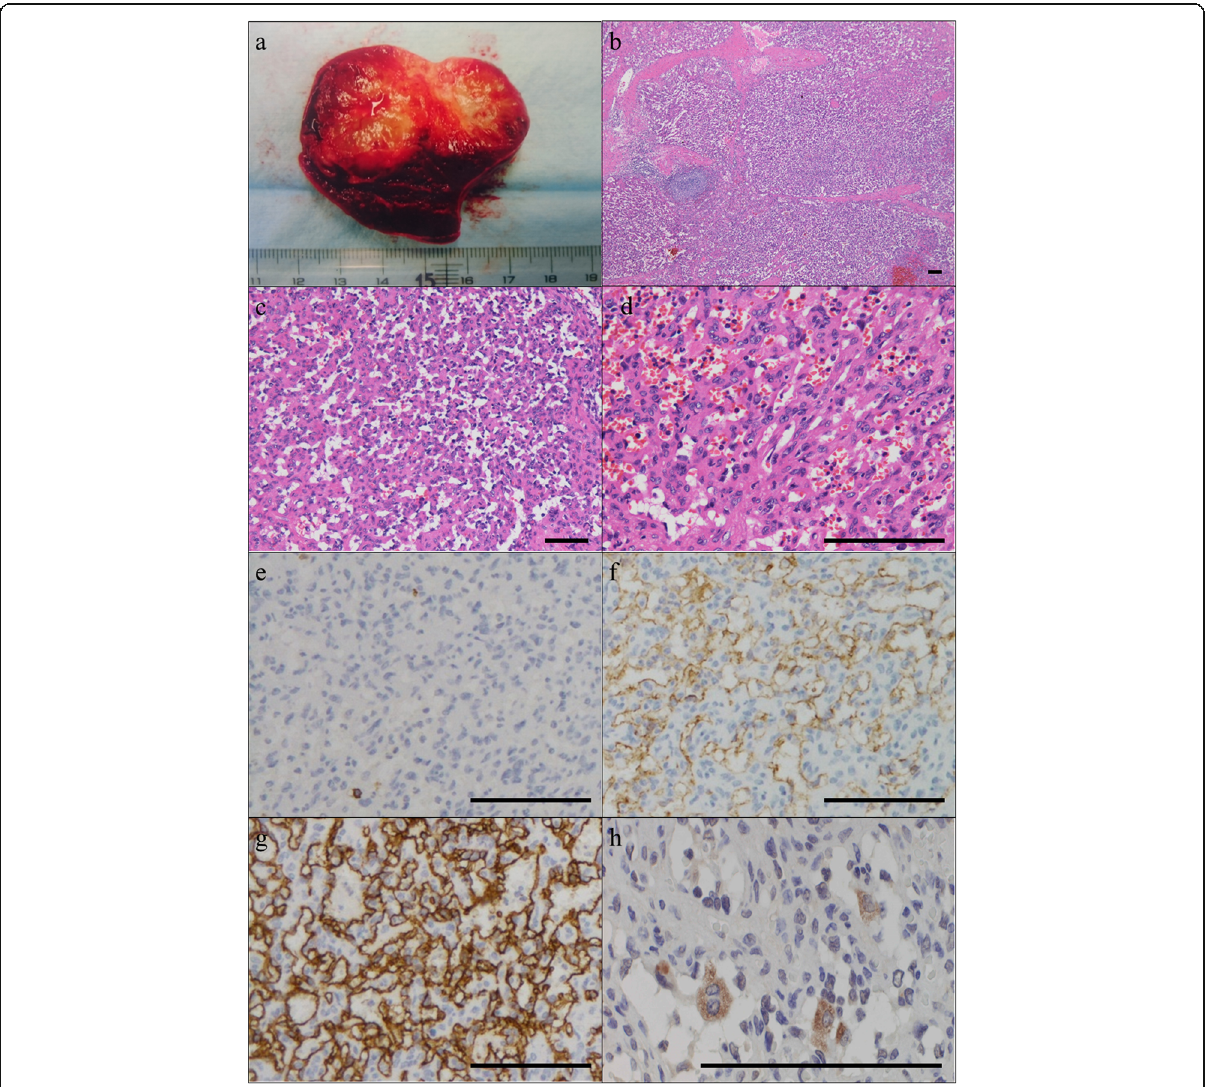
Fig. 2 Macroscopic and microscopic findings. ( a ) Macroscopic findings. The solid tumor (3.5 × 2.7 × 2.5 cm) was encapsulated by spleen parenchyma, and the cut surface was a yellowish white. ( b, c ) Microscopic findings on hematoxylin and eosin (HE) staining. Each lobular lesion was surrounded by fibrous tissue and filled with blood cells (B HE × 40, C HE× 100). ( d ) The lesions consist of many vascular channels (HE × 100). Immunohistochemical findings of the lesion. ( e ) Negativity of capillaries and small veins for CD8 (× 100) and ( f ) positivity for CD31 (× 100). Only lymphocytes were positive for CD8 ( e ). ( g ) Positivity of capillaries for CD34 (× 100). ( h ) Some tumor cells were positive for IGF-II (× 400). Bar scale, 100 μ m.